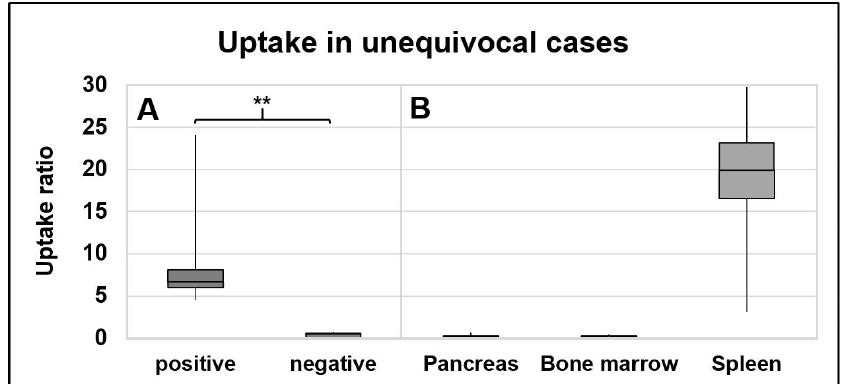
Figure 3. Uptake quantification in RBC scintigraphy in unequivocal cases. ( A ) = Uptake in suspected splenic lesions. ( B ) = Uptake in sites of physiologic uptake. Referenced to liver uptake (uptake ratio). Positive = consensually rated as splenic tissue. Negative = consensually rated as non-splenic tissue. ** p < 0.01.